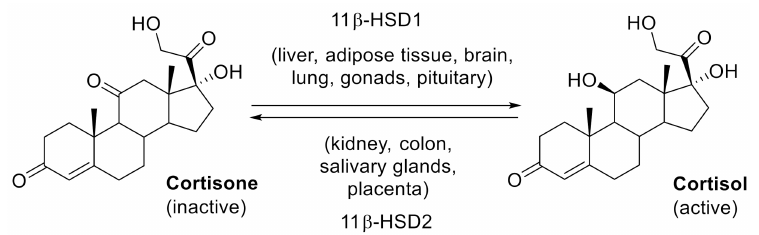
Scheme 1. The physiological role of the two isoforms of 11 β